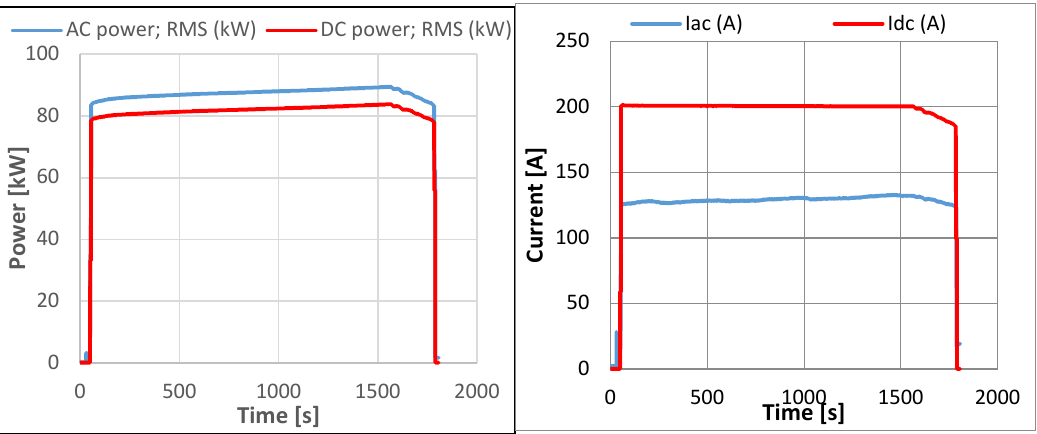
Figure 3. AC and DC power and current during a recharge (HPCS 1 slave, Table 2 measurements) .